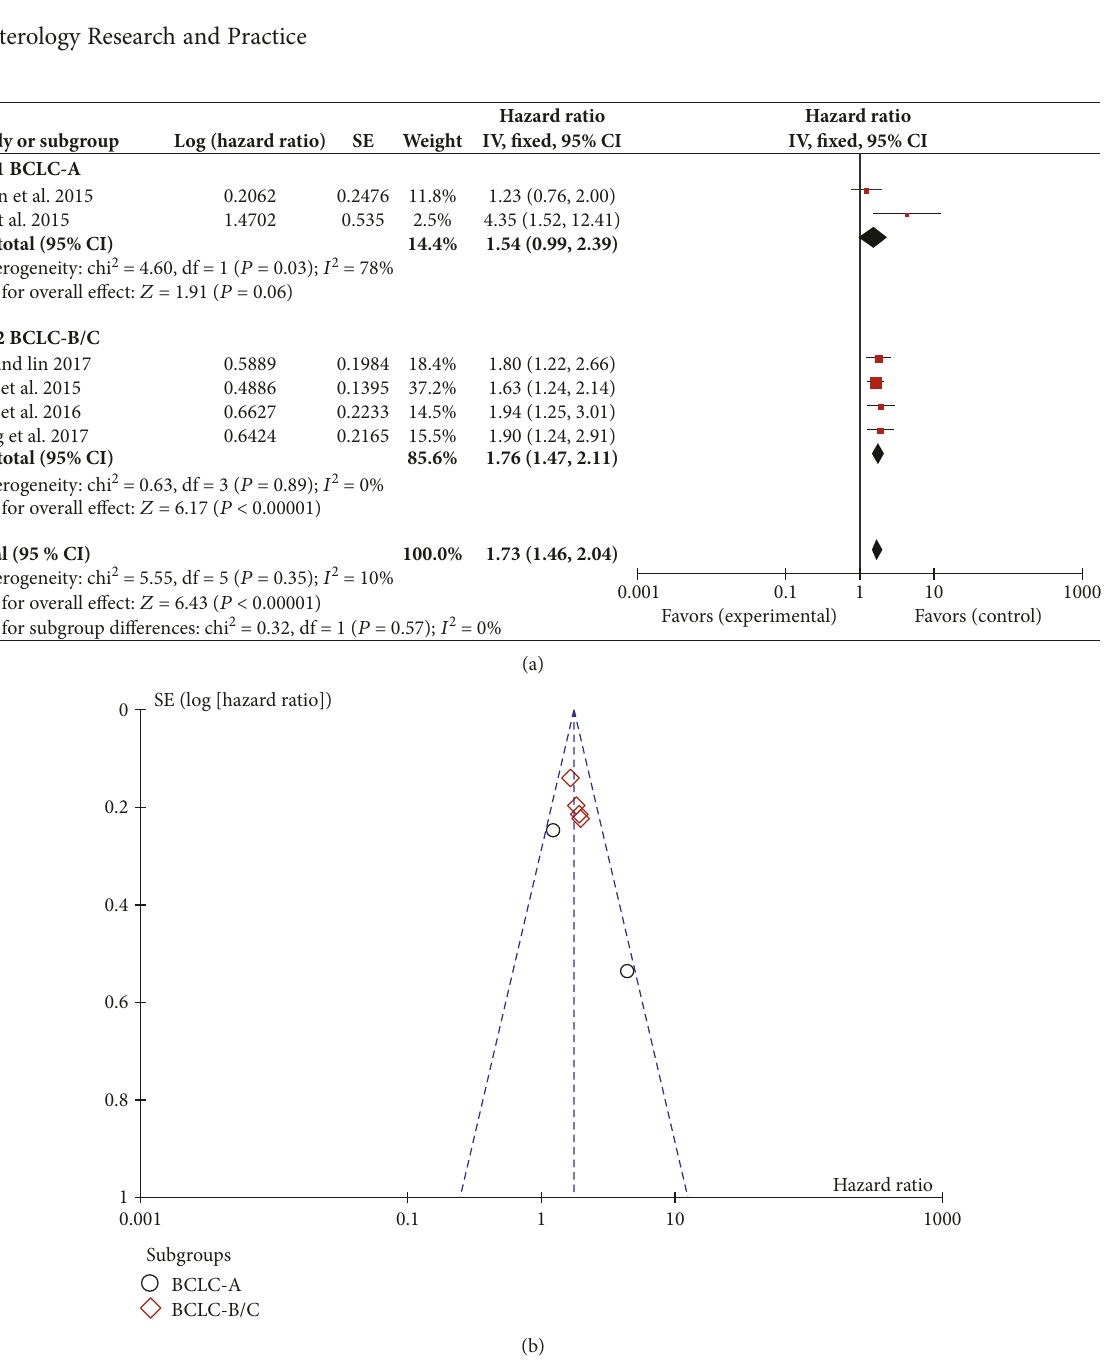
Figure 2: Correlation between platelet-to-lymphocyte ratio and overall survival. (a) Forest plot of comparison of the included trials; (b) funnel plot of comparison of the included